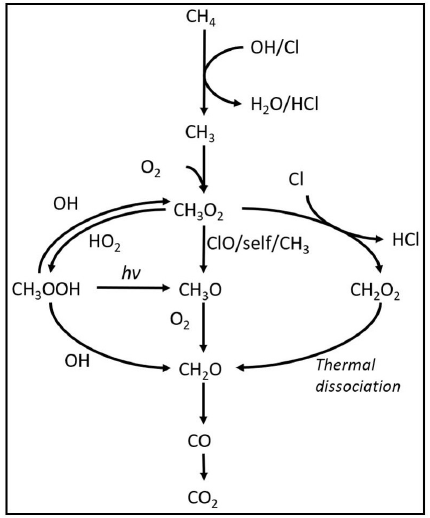
Figure 2. Reaction scheme for the oxidation of methane to CO 2 . CH 3 O 2 self-reactions lead to the formation of CH 3 O. with 1.25 g of sofnocat contained in a 1 / 4 (cid:48)(cid:48) stainless-steel tube of length 8 cm kept in place by glass